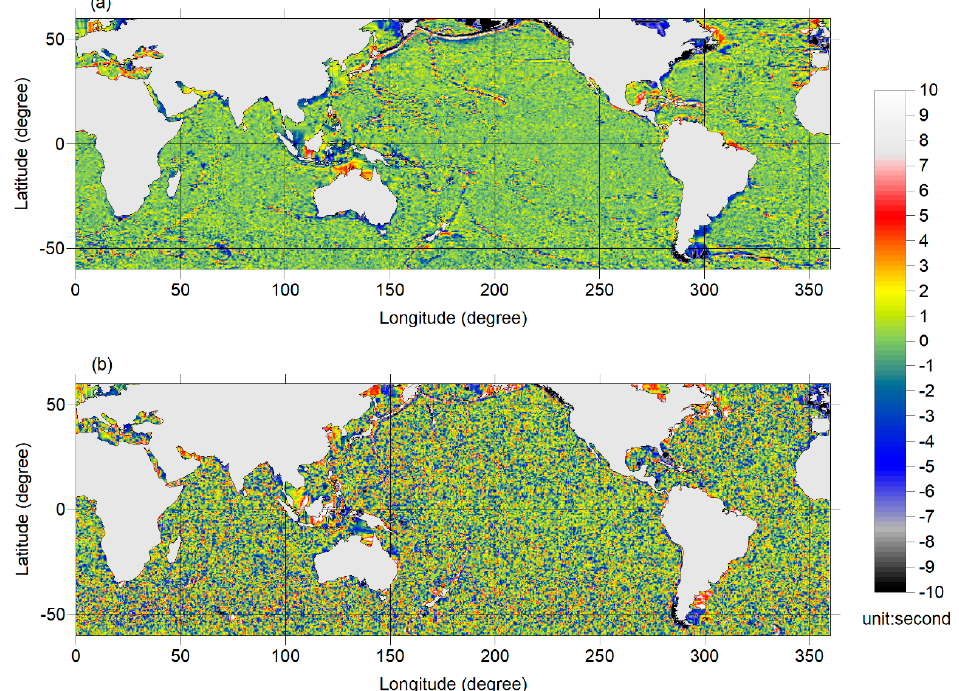
Figure 3. Differences between vertical deflections derived from HY-2A observations and EGM2008: ( a ) North component; ( b ) East component.